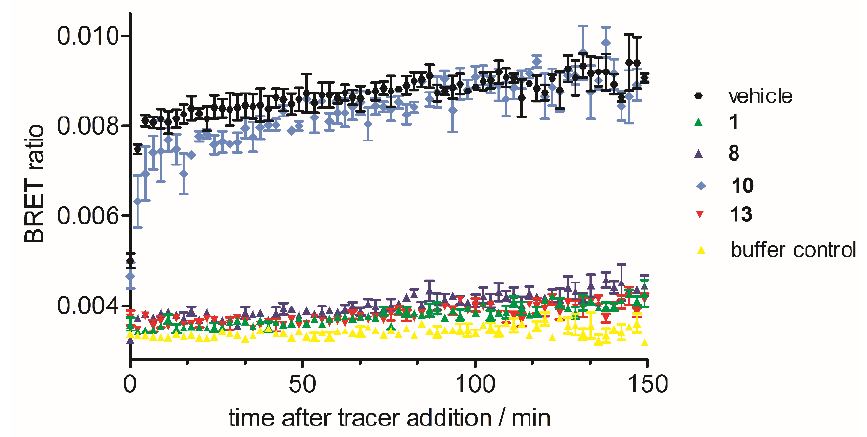
Figure 5. Kinetic analyses of compounds 1 , 8 , 10, and 13 .